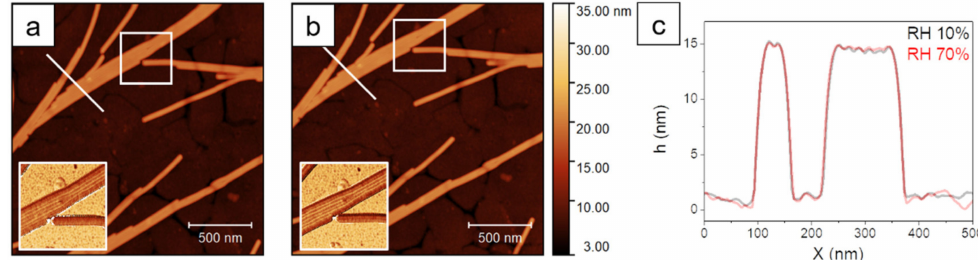
Figure 1. AFM images of Tobacco Mosaic virions on gold at 10% RH ( a ) and at 70% RH ( b ) obtained from standard tapping mode imaging with single frequency excitation. The insets of ( a , b ) show Φ 1 images of the areas enclosed in the white frames. Topographic profiles at the two different humidity levels are shown in ( c ). They refer to the white lines in ( a , b ).